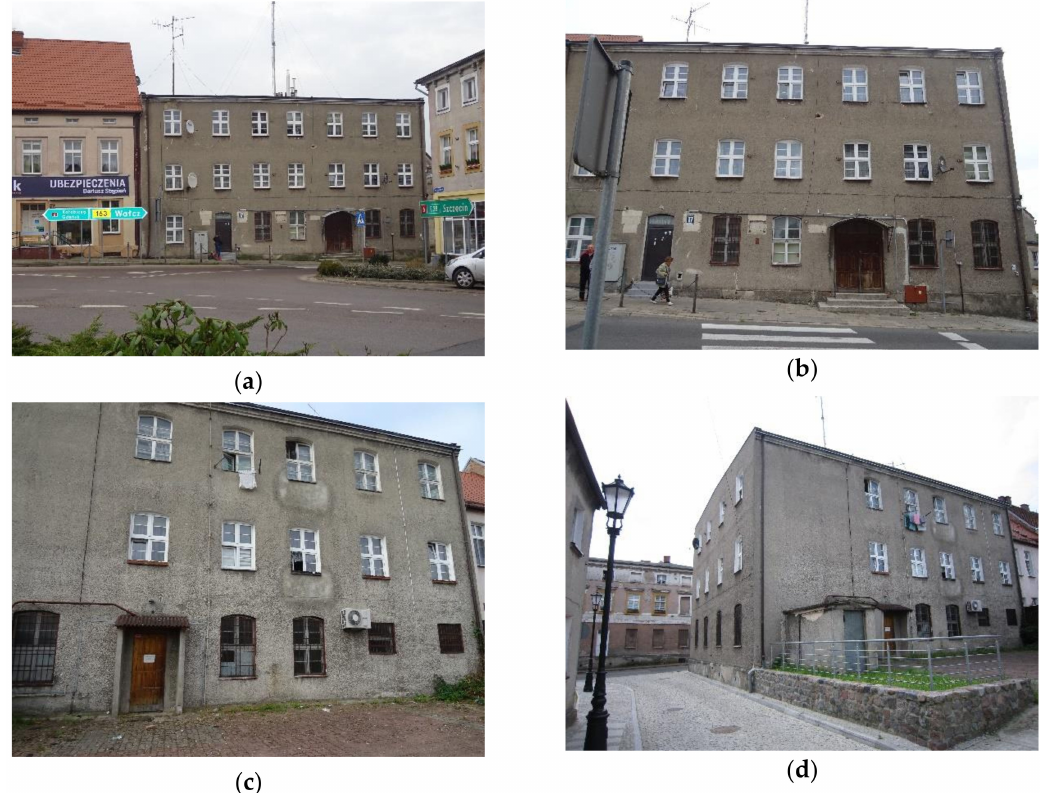
Figure 1. View of the building: ( a ) front; ( b ) front; ( c ) back; ( d )